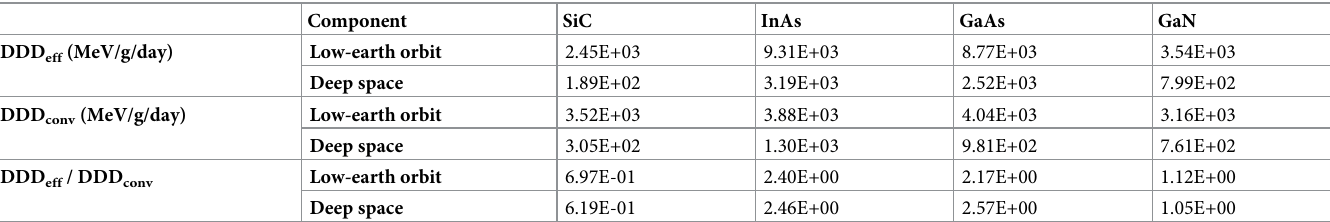
Table 2. DDD eff , DDD conv and DDD eff / DDD conv for SiC, InAs, GaAs and GaN exposed to cosmic rays in low-Earth orbit and deep space. Component SiC InAs GaAs GaN DDD eff (MeV/g/day) Low-earth orbit Deep space DDD conv (MeV/g/day) Low-earth orbit Deep space Low-earth orbit Deep